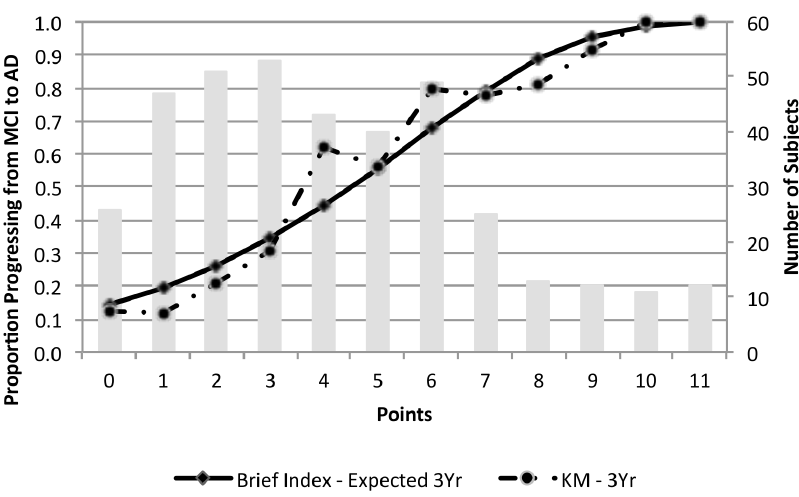
Fig. 1. Observed versus Predicted Conversion from Amnestic MCI to AD over 3 Years by Brief Clinical Index Point Score. The solid line shows the proportion of subjects predicted to progress from amnestic mild cognitive impairment (MCI) to probable Alzheimer’s disease (AD) over three years as function of their brief clinical index point score, while the dotted line shows the actual proportions that progressed at each point score value based on three-year Kaplan-Meier (KM) estimates. The vertical bars show the number of individuals at each point score value (right vertical